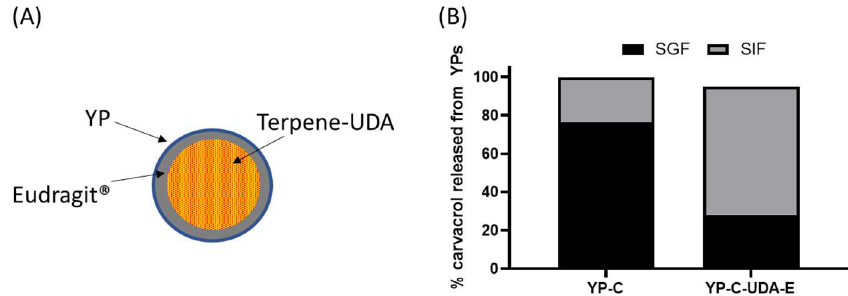
Figure 6. ( A ) Schematic of a YP–terpene–UDA particle coated with Eudragit ® polymer and ( B ) carvacrol released from YPs in YP carvacrol (YP-C) control sample and YP carvacrol co-loaded with UDA and coated with Eudragit ® L-100 (YP-C-UDA-E). The release assay was performed by sequential incubation of YP samples in simulated gastric fluid (SGF) at 37 ◦ C for 2 h followed by in- cubation in simulated intestinal fluid (SIF) at 37 ◦ C for 2 h. Carvacrol concentration during simulated digestion was 1